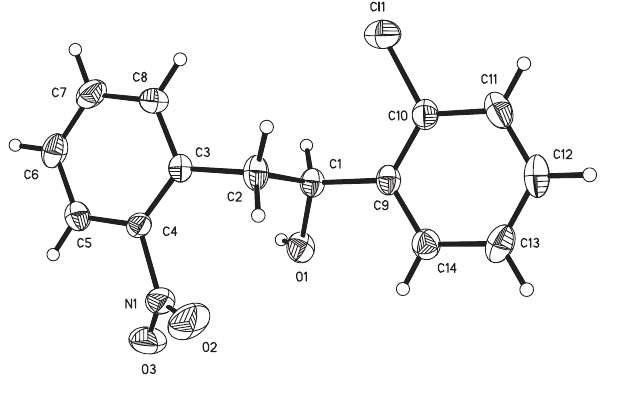
Table 1: Data collection and handling.